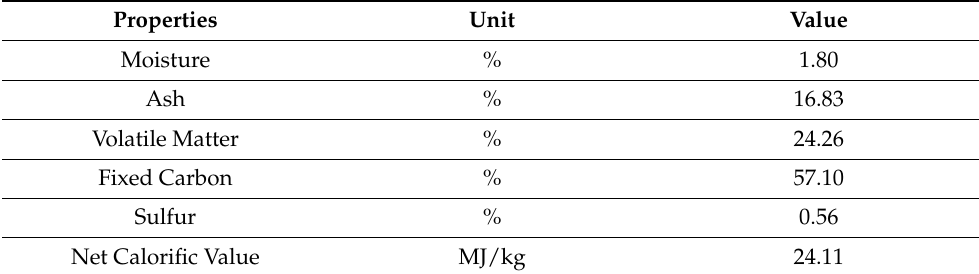
Table 1. Properties of coal under the air-dried